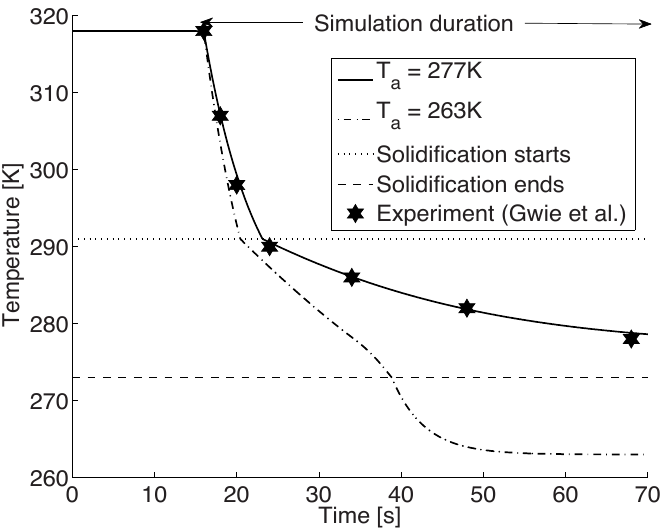
Figure 1. Temperature profile of a 2 mm droplet, initially at 318 K, suspended in a chamber that is at 277 K and 1 bar, along with the experimental data of Gwie et al. [26] (asterisk symbol, copyright permission has been obtained). An additional simulation is performed at T a = 263 K. The start of solidification is at 291 K and the solidification ends at 273 K. (Figure reproduced from [42,43] by resimulating the